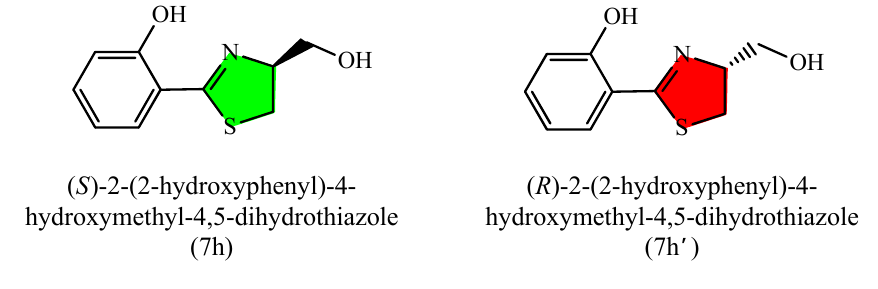
Figure 1. Chemical structures of (S) -2-(2-hydroxyphenyl)-4-hydroxymethyl-4,5-dihydrothiazole and (R) -2-(2-hydroxyphenyl)-4-hydroxymethyl-4,5-dihydrothiazole.